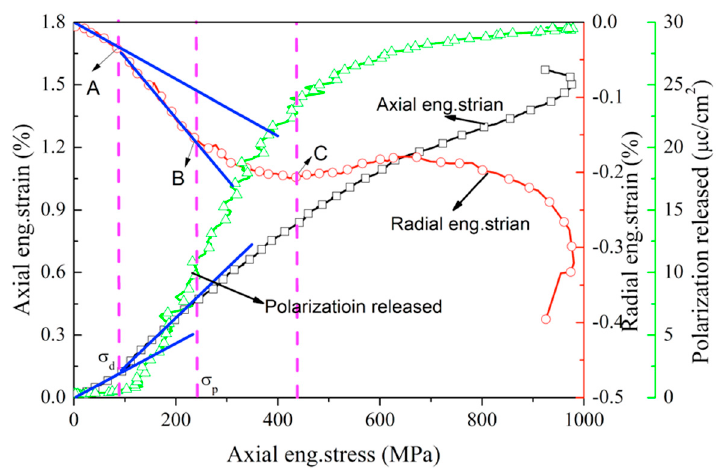
Figure 8. Axial eng.stress vs. axial eng.strain, radial eng.strain and polarization released curves for poled porous ceramics with ≈ 11% porosity at the strain rate of 300 s − 1 .